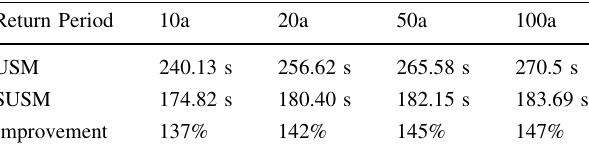
Table 3 Comparison of the two models in terms of the computational time cost (CPU time)